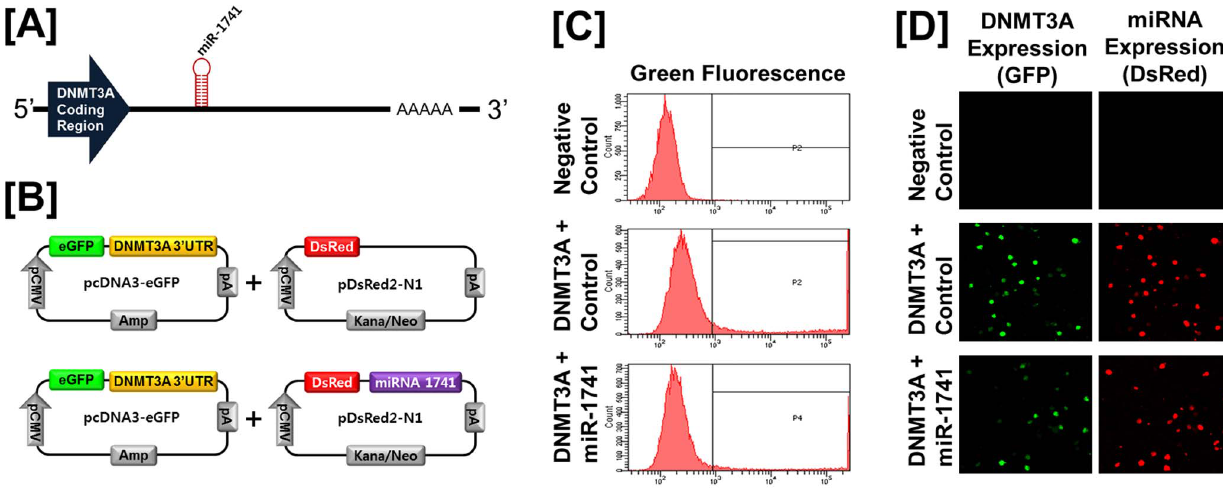
Figure 3. In vitro target assay for microRNAs of the DNMT3A transcript. [A] Diagram of miR-1741 binding site in the DNMT3A 3 9 -UTR. [B] Expression vector map for eGFP with DNMT3A 3 9 -UTR and Ds-Red with miR-1741 . [C and D] After co-transfection of pcDNA-eGFP-3 9 -UTR for the DNMT3A transcript and pcDNA-DsRed-miRNA for the miR-1741 , the fluorescence signals of GFP and DsRed were detected using FACS [C] and fluorescent microscopy [D].